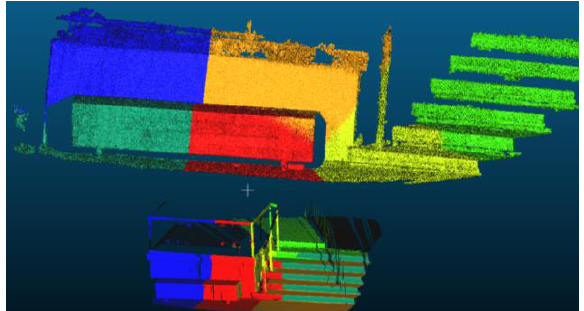
Figure 2: Surface normal, TLS (below) and Photogrammetry (above) K-means Segmentation